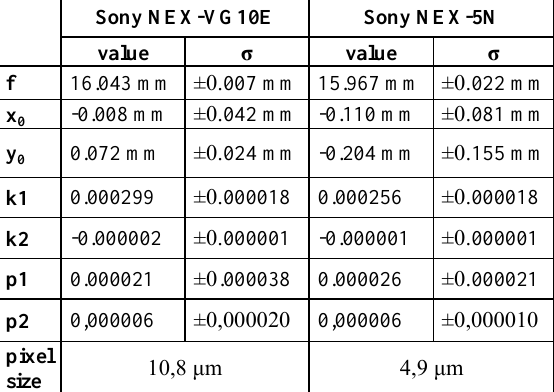
Table 1. Results of two video camera’s